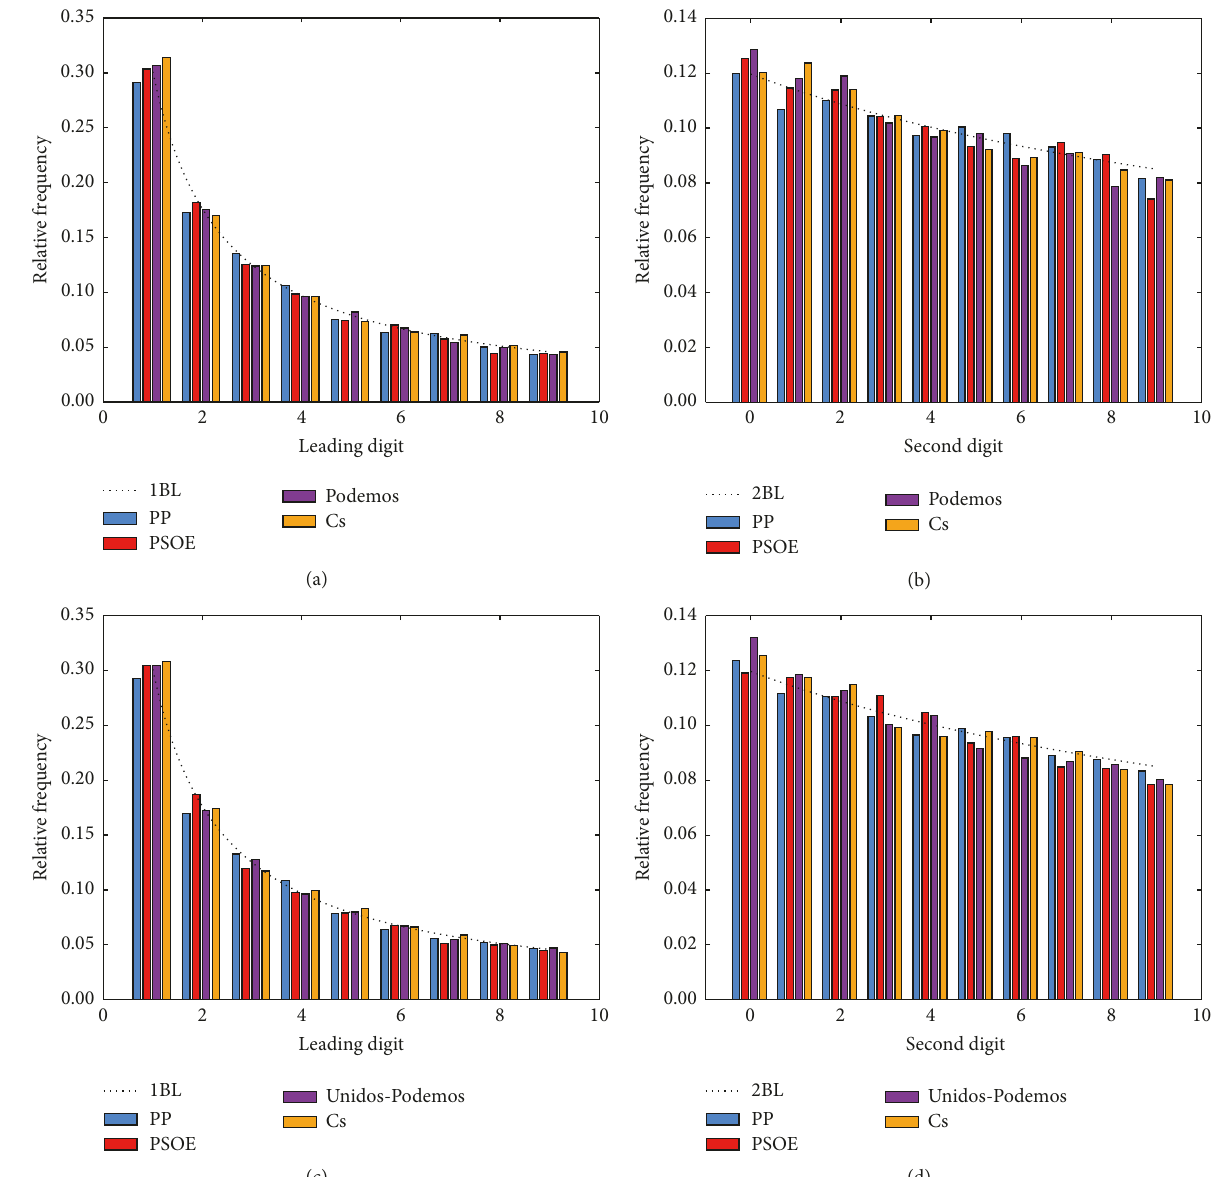
Figure 7: Histograms of relative frequencies for the first (a, c) and second (b, d) significant digits of the four most important political parties vote counts over municipalities (more than 8000 in each case) for the 2015 (a, b) and 2016 (c, d) elections.